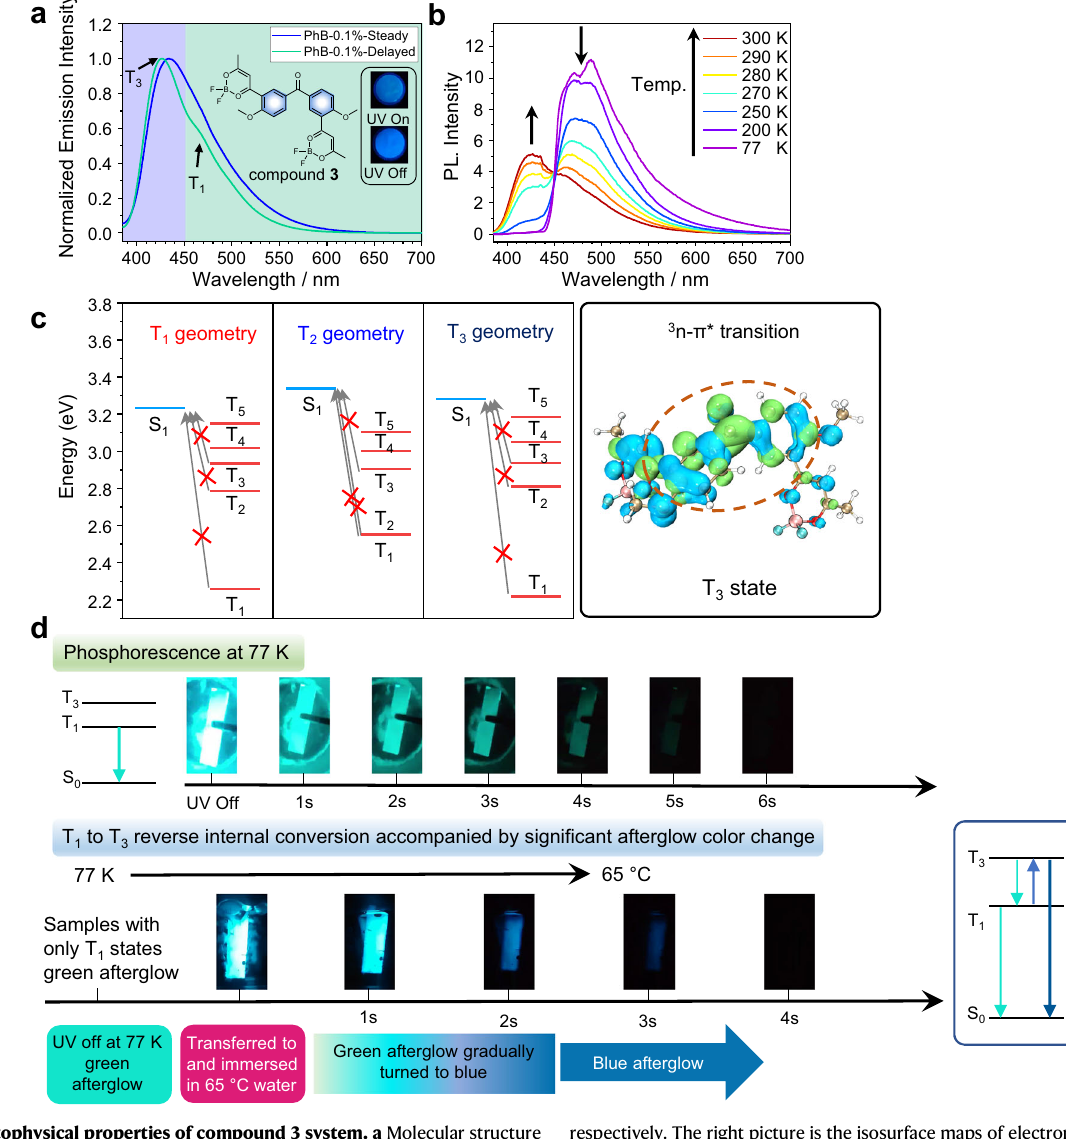
respectively. The right picture is the isosurface maps of electron-hole density dif- ference of 3 ’ s T 3 state calculated at the S 0 geometry with B3LYP/G functional and def2-TZVP(-f)basisset; d Phosphorescencephotographsofmelt-cast fi lmof 3 -PhB- 0.1% at 77K, photographs showing the phenomenon of afterglow color change whentransferring 3 -PhB-0.1%melt-cast fi lmfromliquidnitrogen(77K)tohotwater (65°C) and the proposed